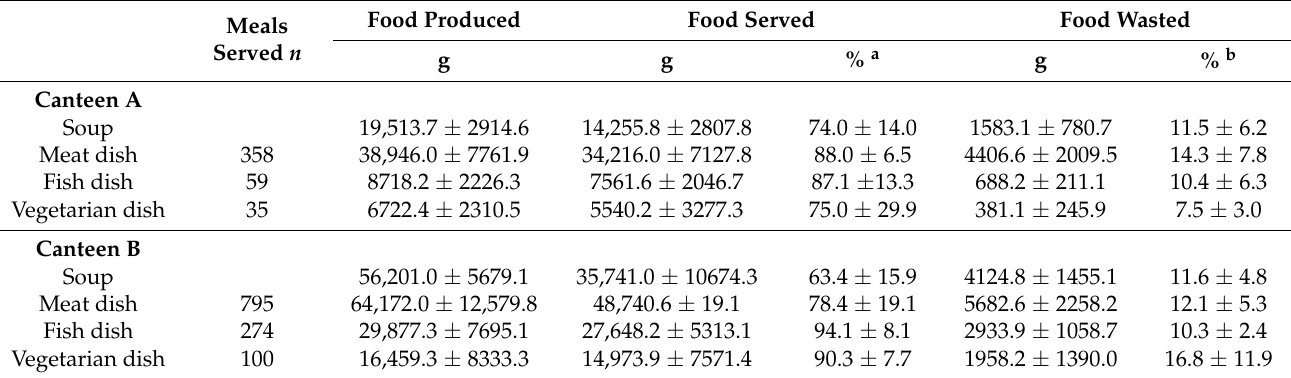
Table 2. Food waste evaluated during 5 weekdays during lunch served in canteens (A and B) from public university. Meals Served n